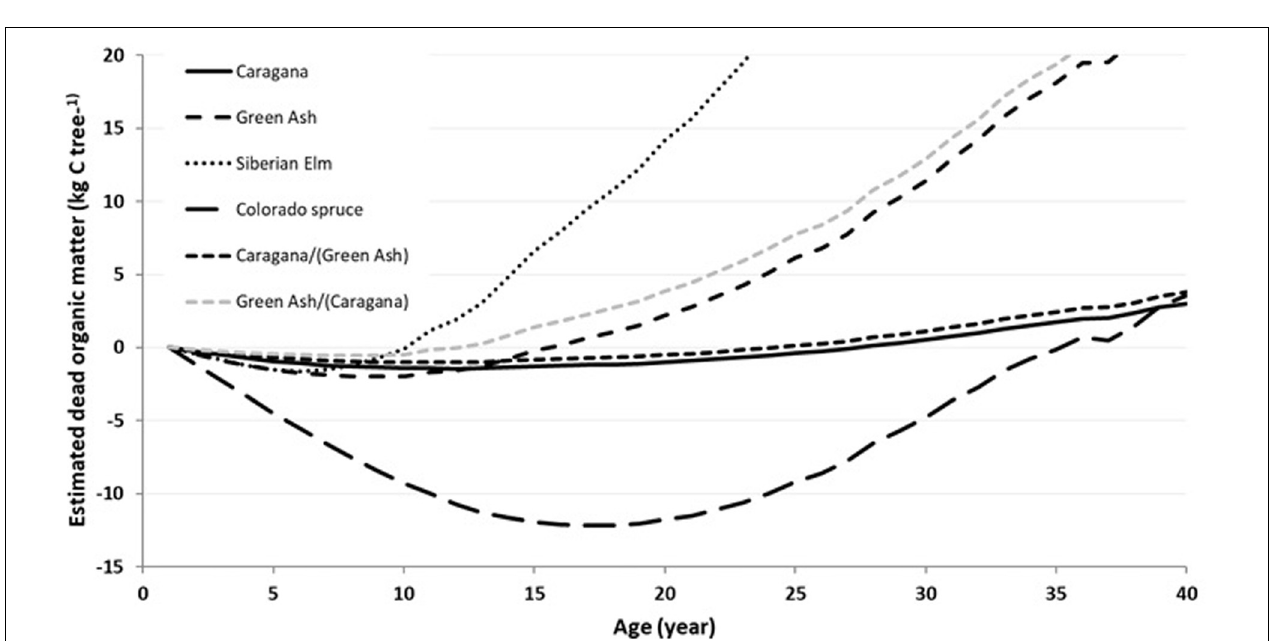
FIGURE 3 | Estimated carbon accumulation in the living biomass of trees grown near Indian Head, SK, Canada, using adjusted values from the representative estimates of Cluster BLK 3 (Amichev et al., 2017).